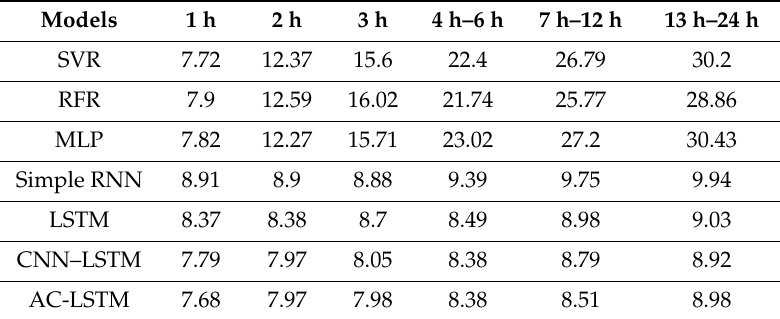
Table 6. The performances of the di ff erent models in terms of mean absolute error (MAE). SVR—support vector regression; RFR—random forest regression; MLP—multilayer perceptron.